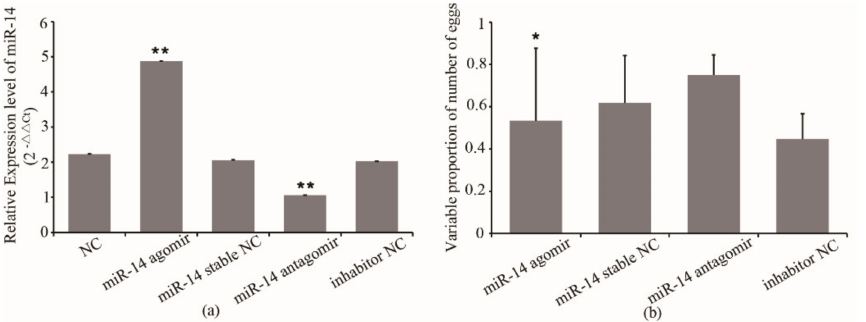
Figure 1. ( a ) The expression of miR-14 in queens after treatment and ( b ) the effect of its expression on the egg number of queens. NC, queens without treatment. miR-14 stable NC, miR-14 stable nonsense sequence control. Inhibitor NC, inhibitor nonsense sequence control. * means p < 0.05, ** means p <